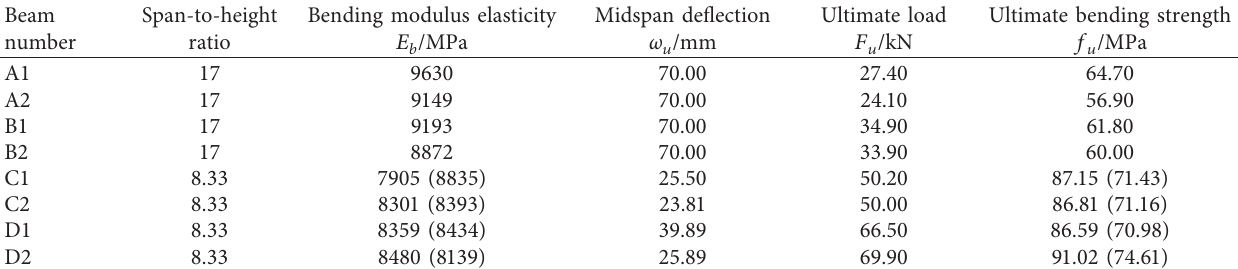
Figure 13: Load-displacement curves. (a) Groups A and B. (b) Groups C and D. (c) Groups E and F. Table 5: The test results of the full-sized members in